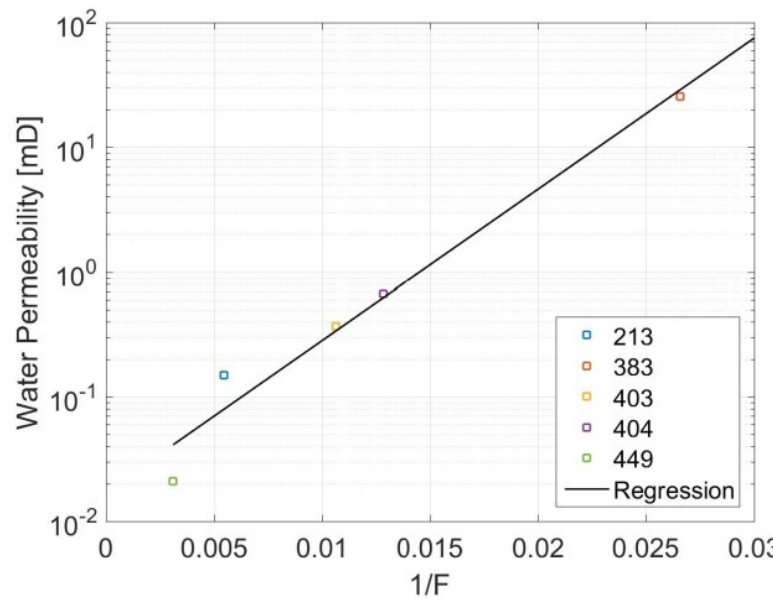
Figure 9. Permeability as a function of 1 / F. The data suggest a clear power correlation with an R 2 value of 0.9674. Table 4. Resistivity and NMR derived sample properties.